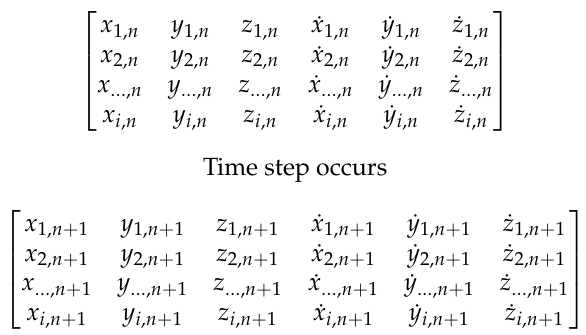
Figure 1. ParticleChromo3D [18] Process